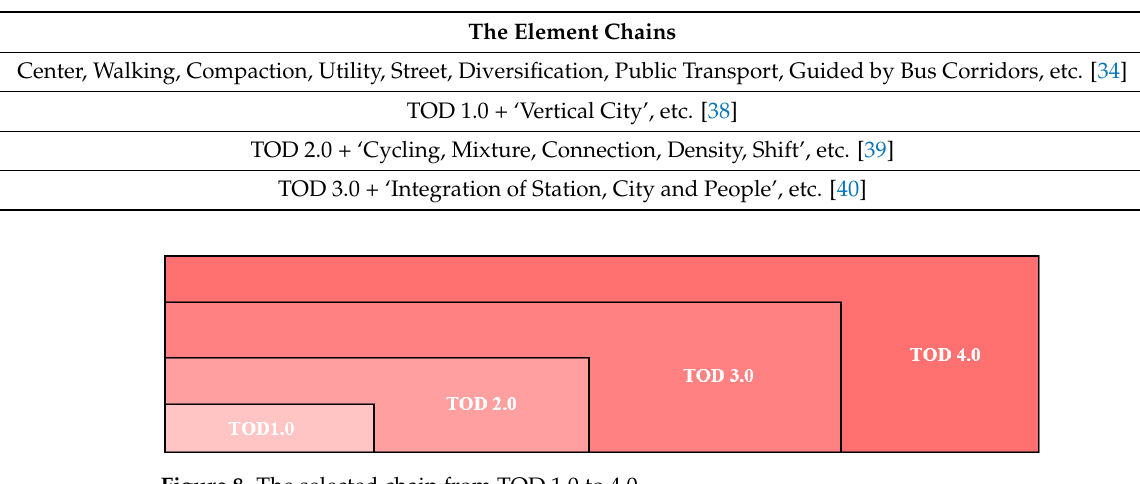
Figure 10. The construction logic of the DNA of S-TOD. We formed a helix DNA for S-TOD, through the integration of Subchain α and Sub- chain β and the combination of their characteristics. The five fragments of the subchains are transformed to be five critical genes of the DNA of S-TOD. Figure 11 illustrates the DNA map of S-TOD including Gene 1 (the inner law), Gene 2 (the response points), Gene